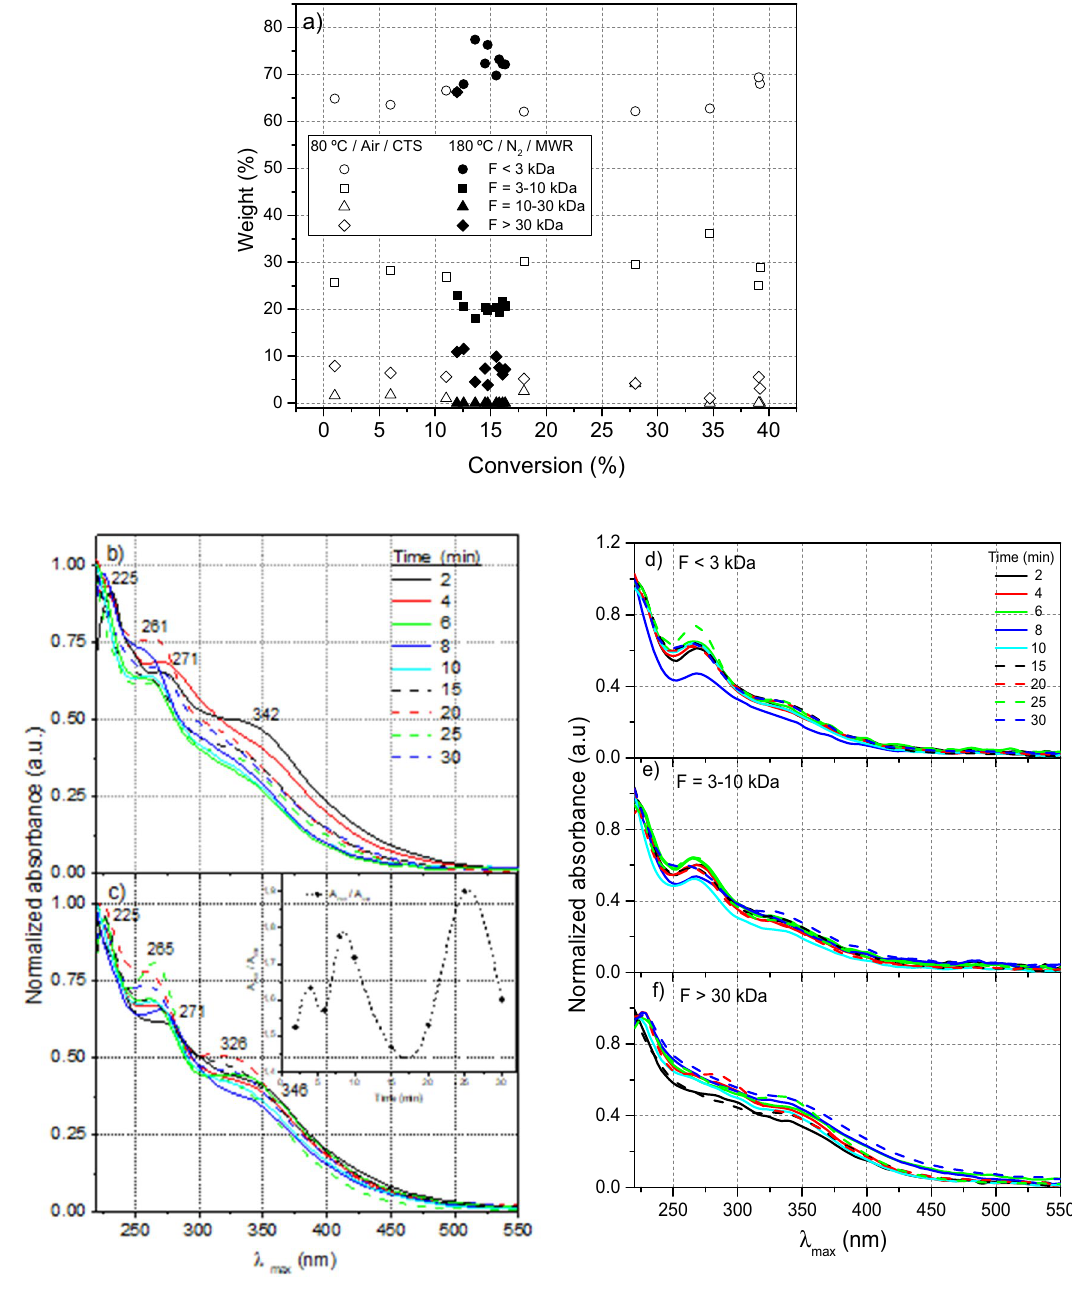
Figure 3. Soluble NH 4 CN polymers (sol fractions) were obtained using microwave-assisted syntheses at 180 °C. ( a ) Weight of sol subfractions concentrated by ultrafiltration using several centrifugal devices with different cut offs. In the picture the apparent molecular weights that present the different subfractions are indicated. The data of the polymers produced at 80 °C using a conventional thermal system (CTS) have never been reported before, and they are shown with comparative purposes. The percentage in weight of each subfraction was calculated as [(mg of sol subfraction) / (mg F > 30 kDa + mg F 10–30 kDa + mg F 3–10 kDa + F < 3 kDa)] · 100. Representative UV–vis spectra: ( b ) of raw sol fractions synthetized in the presence of air; ( c ) of raw sol fractions synthetized under anoxic conditions of a N 2 atmosphere. The inset plot shows the evolution of the relationship between the main bands observed in these spectra over time; ( d ) of the lightest sol fractions with apparent molecular weights below 3 kDa; ( e ) of the light sol fractions with apparent molecular weights from 3 to 10 kDa; ( f ) for the heaviest sol fractions with apparent molecular weights above 30